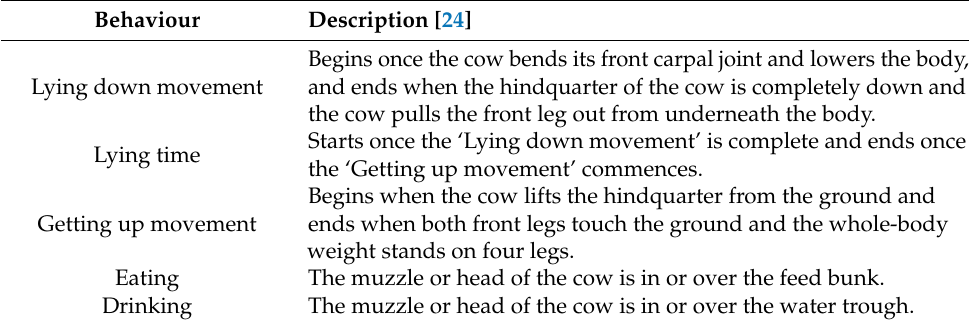
Table 1. Ethogram of cows recorded during Experiments 1 and